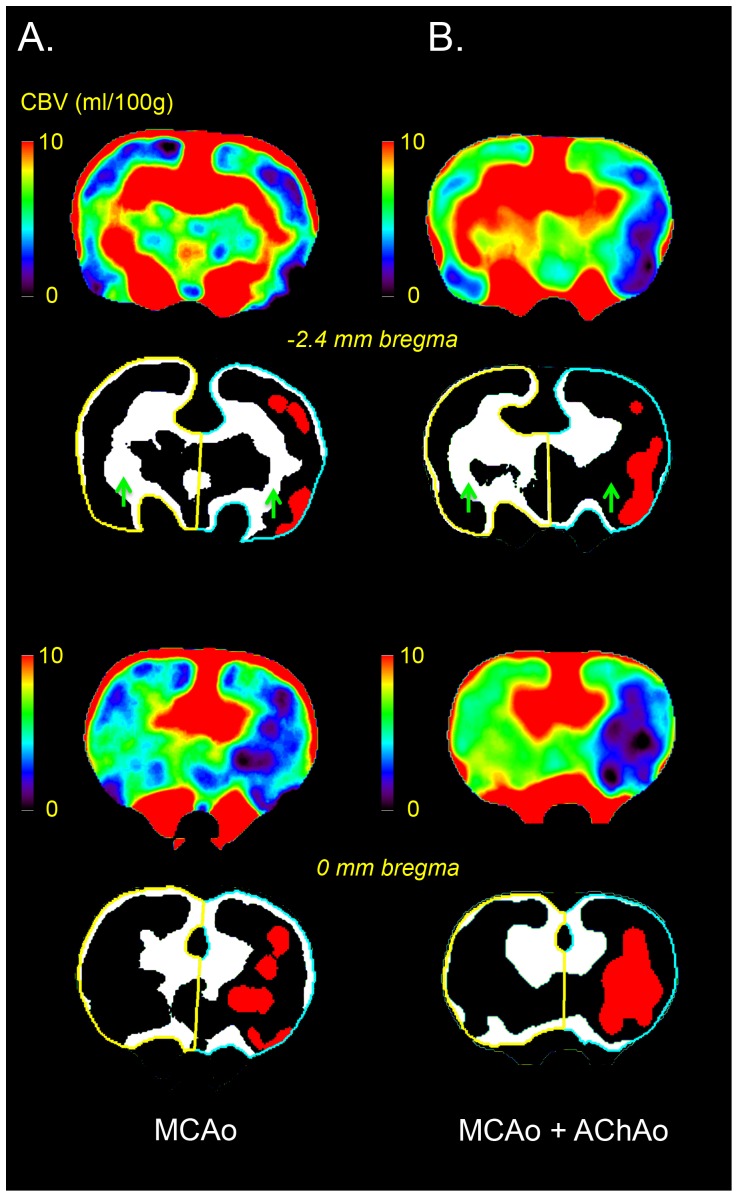
Perfusion Computed Tomography (CTP) analysis method.Cerebral blood volume (CBV) maps (coronal plane) from two rats taken immediately after intraluminal thread occlusion of the middle cerebral artery (MCAo). The animal in column A is seen to have MCAo with preserved AChA blood volume whereas the animal shown in column B has both MCAo and anterior choroidal artery occlusion (AChAo). For each rat, 2 bregma levels are shown, with the top 2 images showing the more caudal sections. At each level the colour coded CBV maps are shown on top, and underneath a CBV threshold of 10 ml/100 g was applied to all CBV maps to remove large blood vessels, and ROIs encompassing the left (contralateral, yellow outline) and right (ipsilateral, blue outline) hemispheres were generated. Voxels below the mean contralateral CBV were thresholded out to leave the voxels with higher CBV (white). Green arrows indicate the location of the AChA territory. Lack of CBV voxels in the ipsilateral AChA territory (column B, row 2) indicates occlusion of the AChA. For illustrative purposes, a CBV threshold of 2 ml/100 g [19] has been applied to the CBV maps to indicate the areas predicted to infarct within the MCA territory (red).